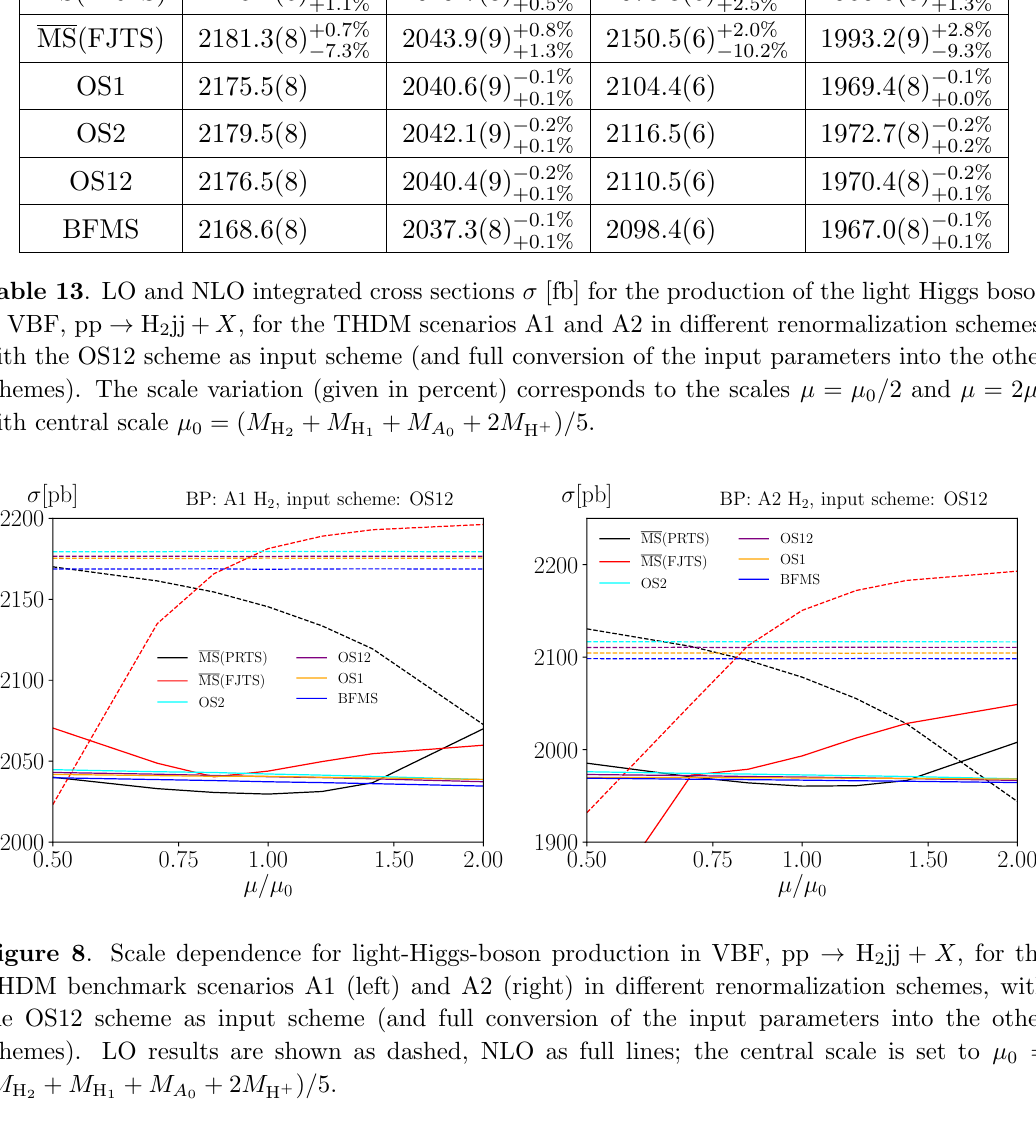
H 2 jj + X , for the !